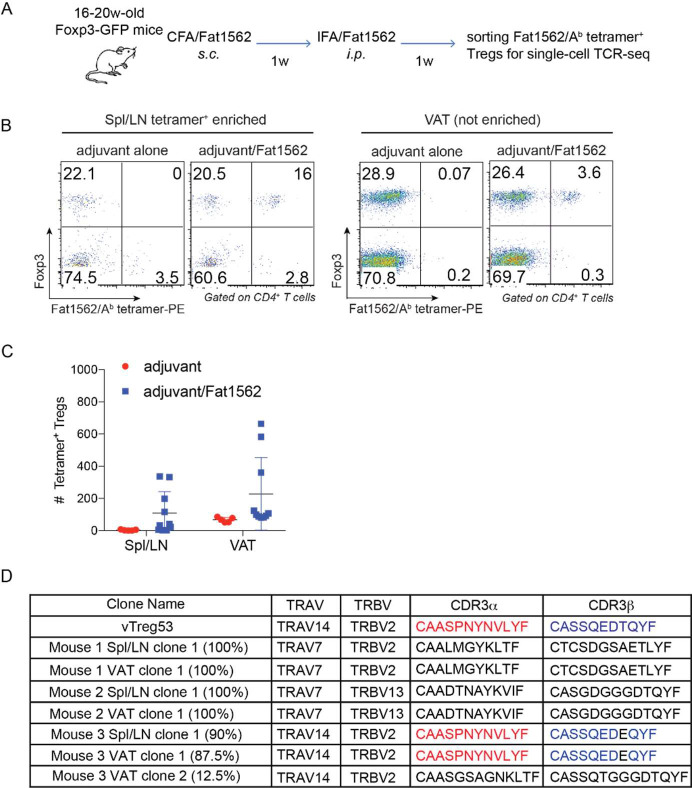
Single cell TCR sequencing (scTCR-seq) analyses of fat1562-reactive endogenous Treg cells following immunization.(A) Scheme of the experiment. (B) Flow cytometric analysis of fat1562/Ab -PE tetramer+ Treg cells in Spl/LNs (enriched by anti-PE beads) or VAT (not enriched) of mice immunized with adjuvant alone or adjuvant/fat1562. Plot is a representative of mice that did show detectable expansion of tetramer+ Tregs. (C) Numbers of fat1562/Ab -PE tetramer+ Treg cells in Spl/LNs or VAT of mice immunized with adjuvant alone or adjuvant/fat1562 (D) Summary of the frequency and CDR3 sequences of expanded fat1562/Ab -PE tetramer+ Treg clones.